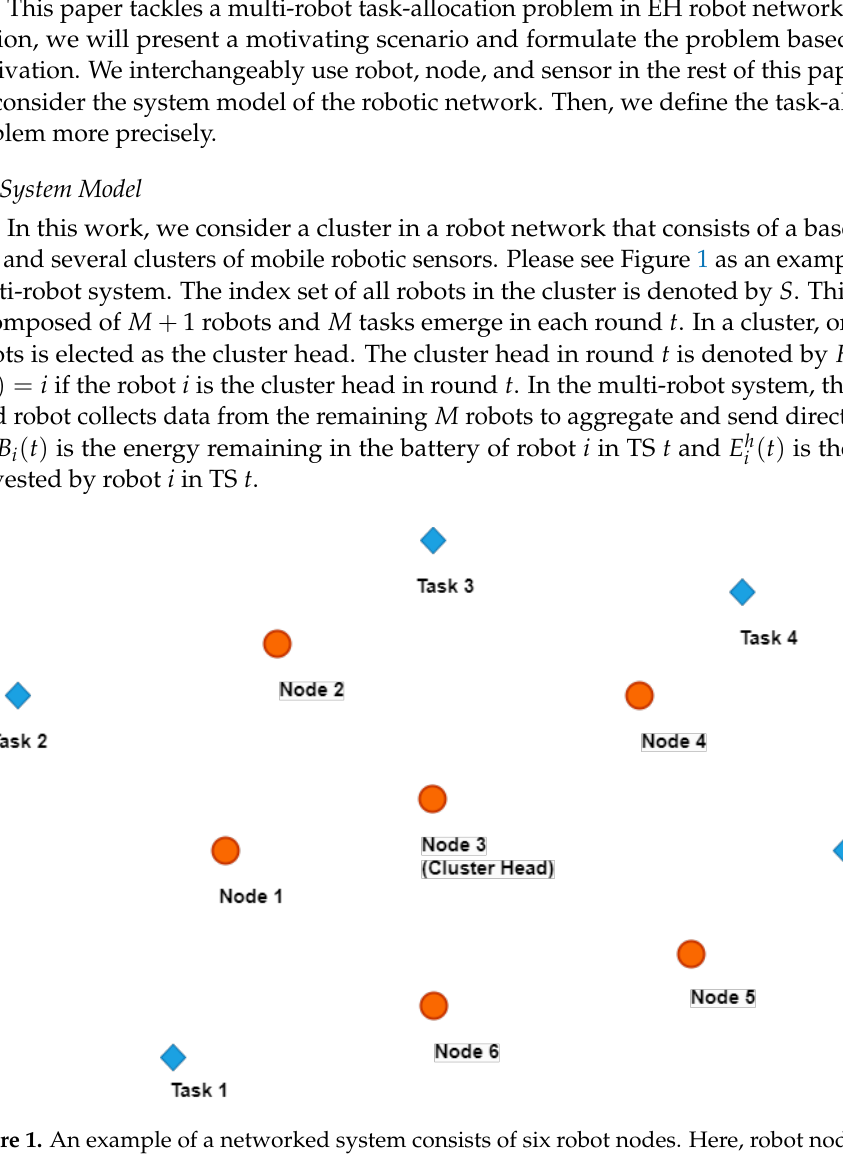
Figure 1. An example of a networked system consists of six robot nodes. Here, robot node 3 is the cluster head robot that assigns one task to each of the remaining five robots. When executing the tasks, these robots benefit from the data collected from the sensors. On the other hand, these sensors are removed for simplicity purposes while illustrating the MRTA